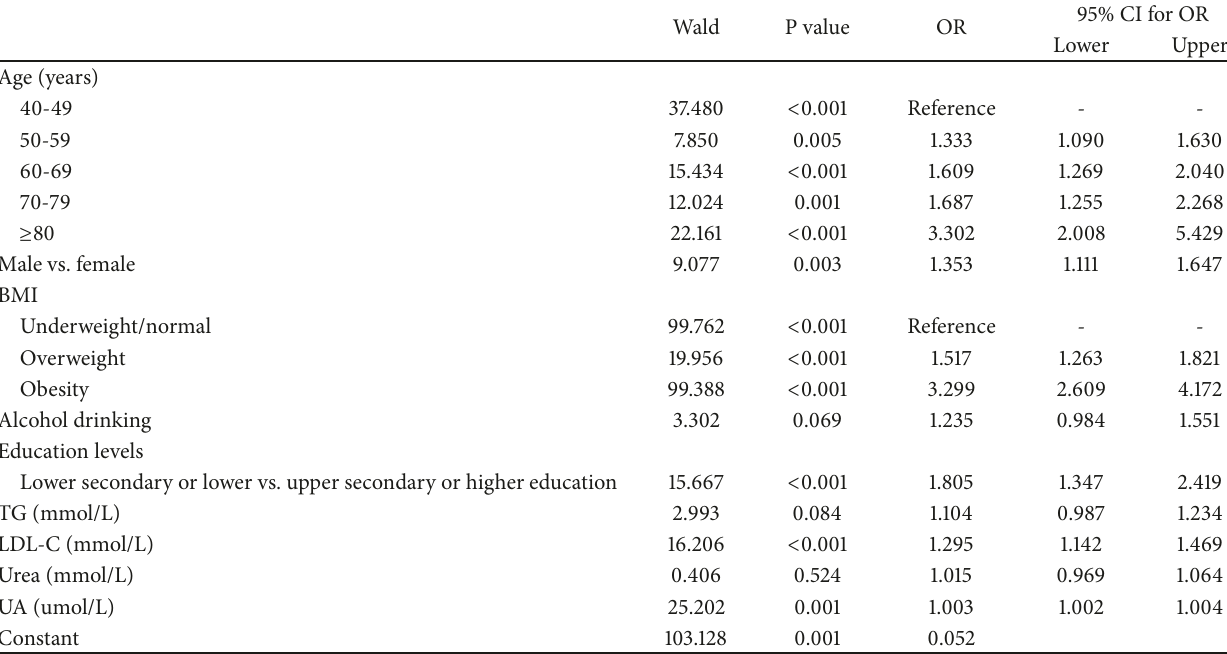
Table 8: Multivariate binary logistic regression analysis of risk factors of hypertension in island